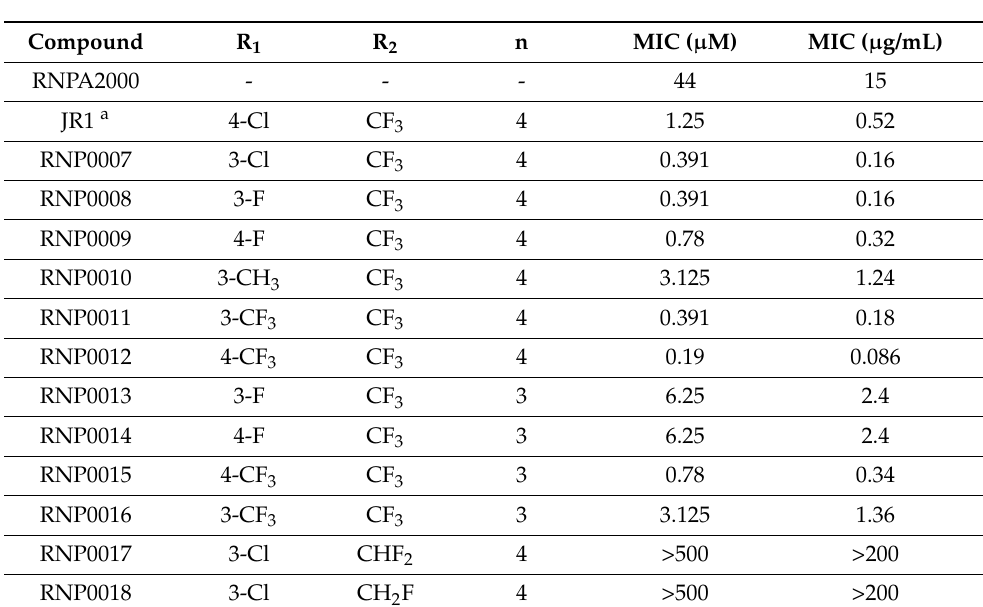
Table 1. Antimicrobial activity of analogs against S. aureus.